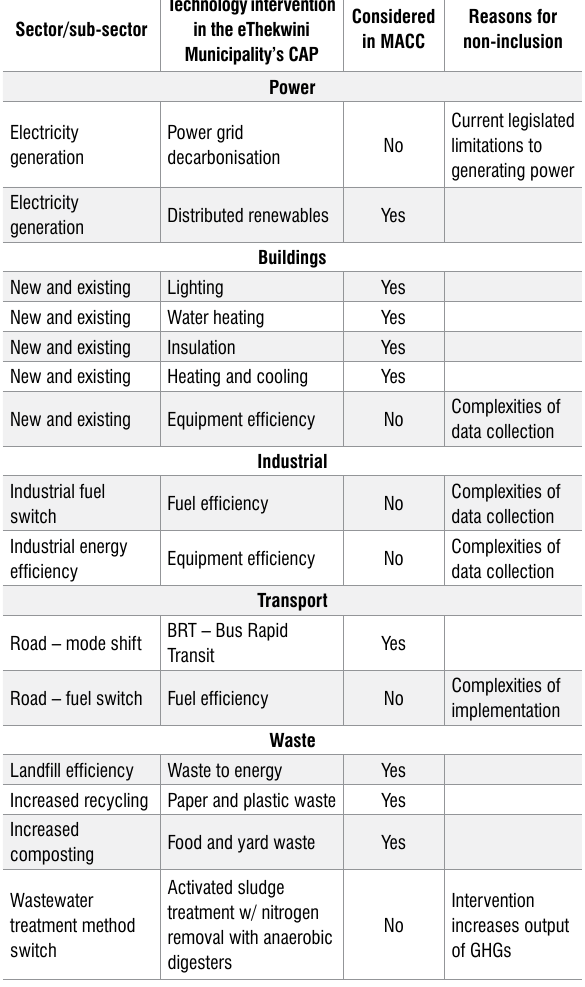
Technological interventions considered in the marginal abatement cost curve (MACC) for the eThekwini Municipality Technology intervention Sector/sub-sector in the